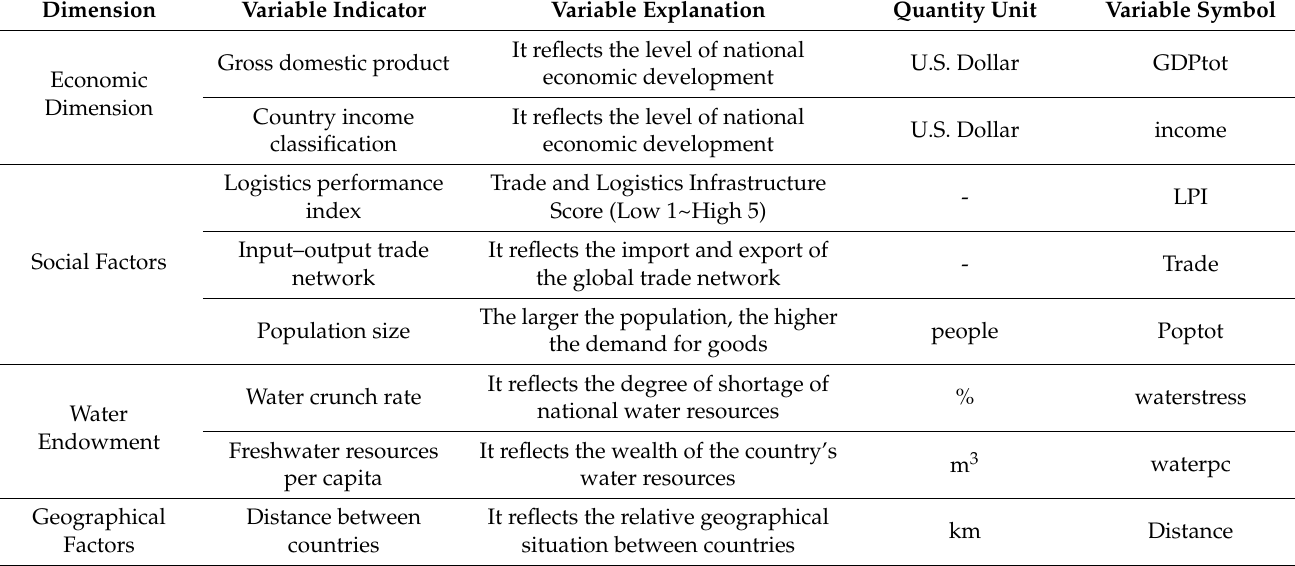
Table 1. Variable selection and variable symbols of the driving force